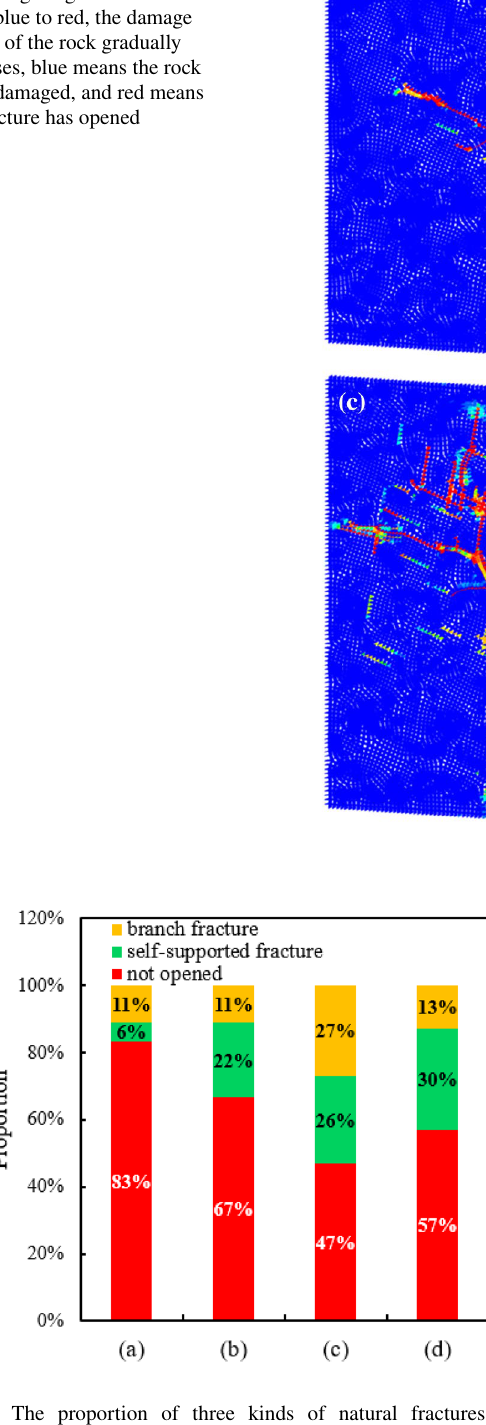
Fig. 9 Fracturing results under different natural fracture distri- butions. The colors represent the damage degree of the rock. From blue to red, the damage degree of the rock gradually increases, blue means the rock is not damaged, and red means the fracture has opened